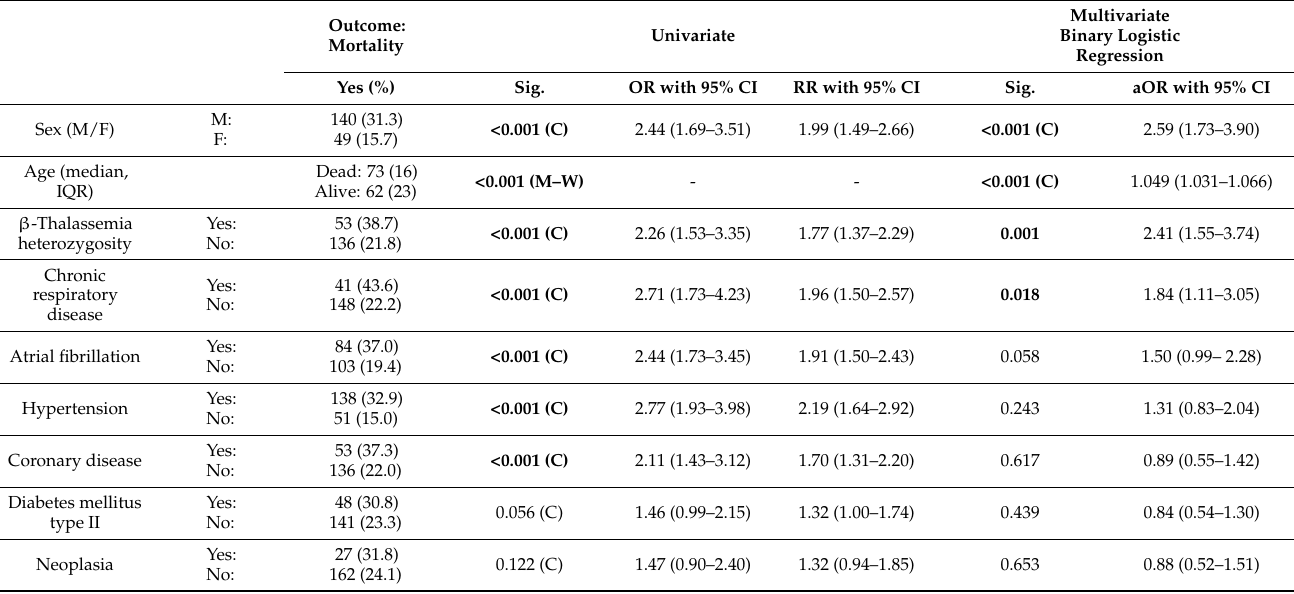
Table 1. Assessing mortality risk of study groups from COVID-19 by univariate and multivariate statistical